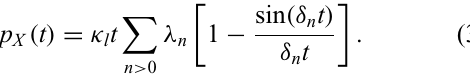
FIG. 1. (a) Bloch-sphere representation of a cat qubit. (b) Energy spectrum of the Kerr Hamiltonian separated in two branches of even and odd parity eigenstates. The ground eigenspace is the cat-qubit manifold (codespace), gapped from excited eigenstates by an − e | ≈ 4 | α | 2 K . Leakage out of the codespace at rate κ energy | e ± 0 1 (cid:2) , where even and odd excited eigenstates dephase at rate δ of all excited states | φ ± n qubit confined with a Kerr Hamiltonian (gray, g ≡ K ) or with two-photon dissipation (green, g ≡ κ 2 ), in units of g . The cat qubit is subject to single-photon loss with rate κ 1 = 10 − 3 g (crosses, solid lines), with additional thermal noise κ 1 n th = 10 − 5 g (diamonds, dashed lines) or pure dephasing κ φ = 10 − 5 g (circles, dotted lines). Markers indicate numerical data, lines indicate analytical